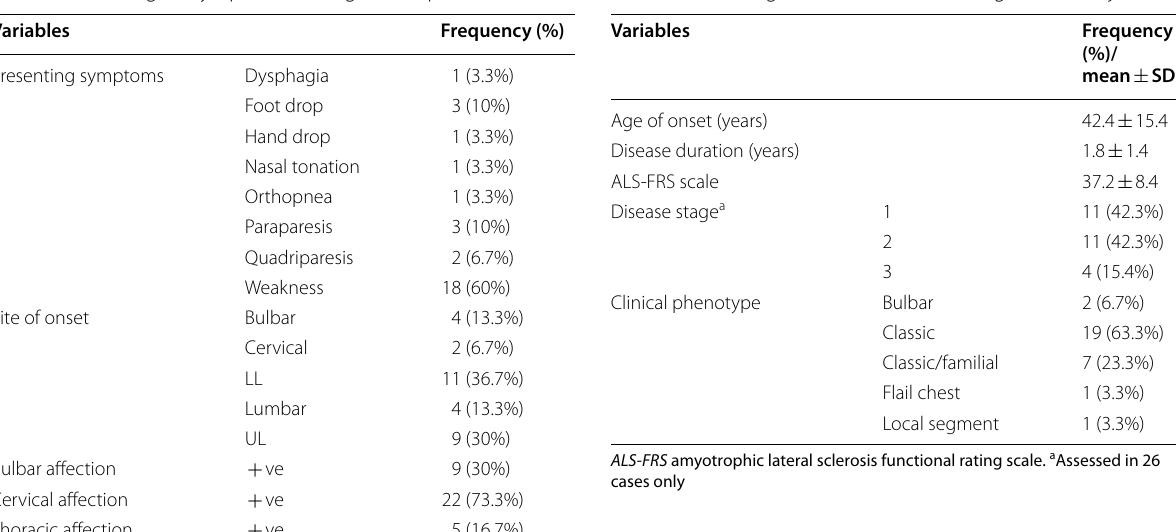
Table 2 Neurological symptoms among 30 ALS patients